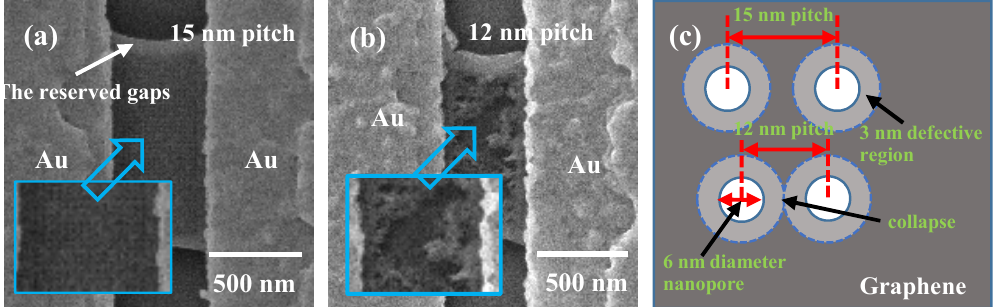
Figure 6. ( a ) GNM with 15 nm pitch after HIBM. ( b ) GNM with 12 pitch after HIBM. ( c ) the schematic diagram to show the defective region surrounding the nanopores. In 12 nm pitch devices, the neck almost consists of defective regions, which caused the collapse.